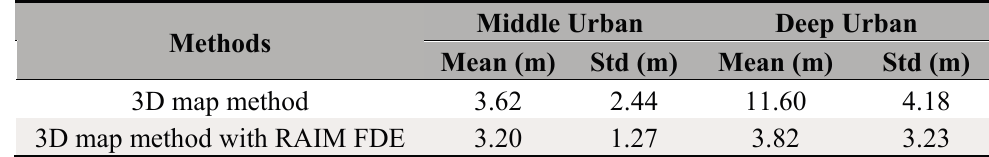
Figure 17. Positioning Results of the static tests using different methods in the ( a ) middle and ( b ) deep urban canyons. Table 5. Horizontal positioning performance of the static tests using the proposed 3D map method before and after using the RAIM